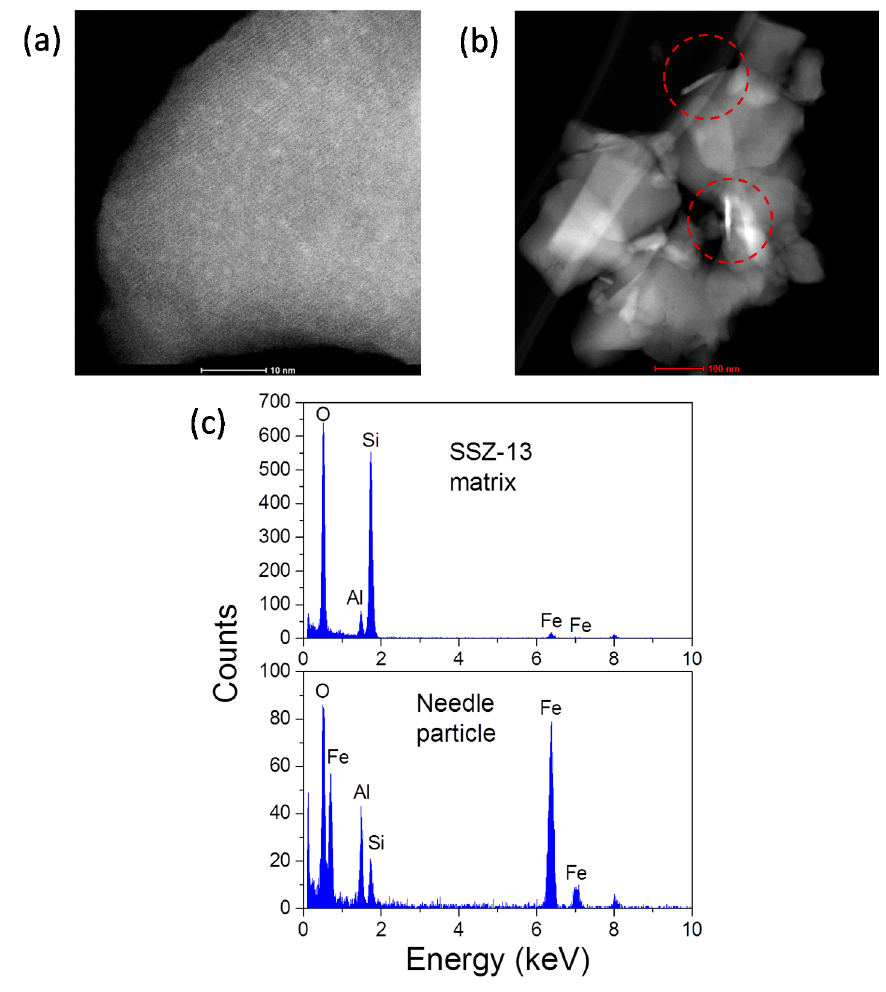
Figure 14. ( a ) TEM image of a representative HTA-800 Fe/SSZ-13 catalyst (1.20% Fe loading) demonstrating formation of Fe-oxide aggregates; ( b ) larger-scale image displaying the preservation of needle-shaped particles; ( c ) EDS of the SSZ-13 matrix (upper panel) and the needle-shaped particles (lower panel). Note that the weak Cu signals at ∼ 8 keV come from the TEM grid rather than the catalyst. Reprinted with permission from [32]. Copyright © 2017 American Chemical Society.